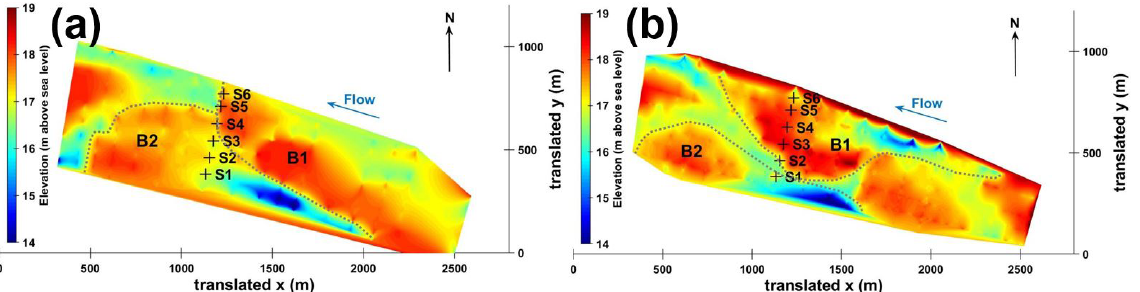
Figure 8. Digital elevation models (obtained using natural-neighbour interpolation of single beam bathymetrical surveys) showing location of sampling points with respect to bar location during (a) the survey of 17 May 2018 ( Q = 604m 3 s − 1 ) and (b) the survey of 19 December 2019 ( Q = 2050m 3 s − 1 ).